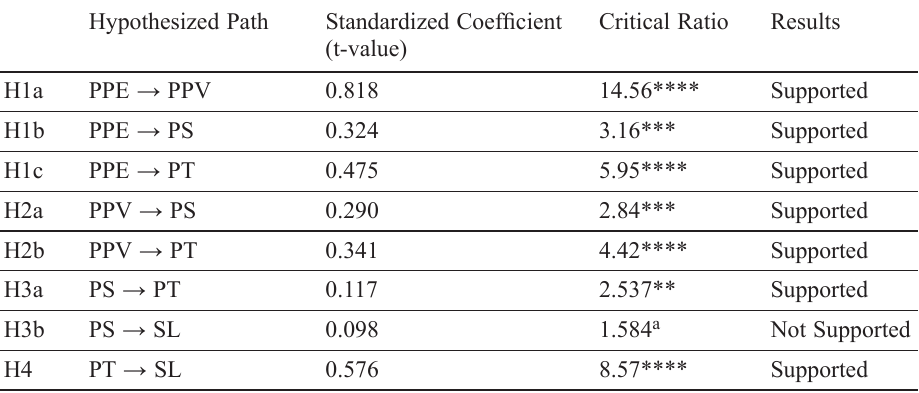
Table 3. Results of the Hypotheses